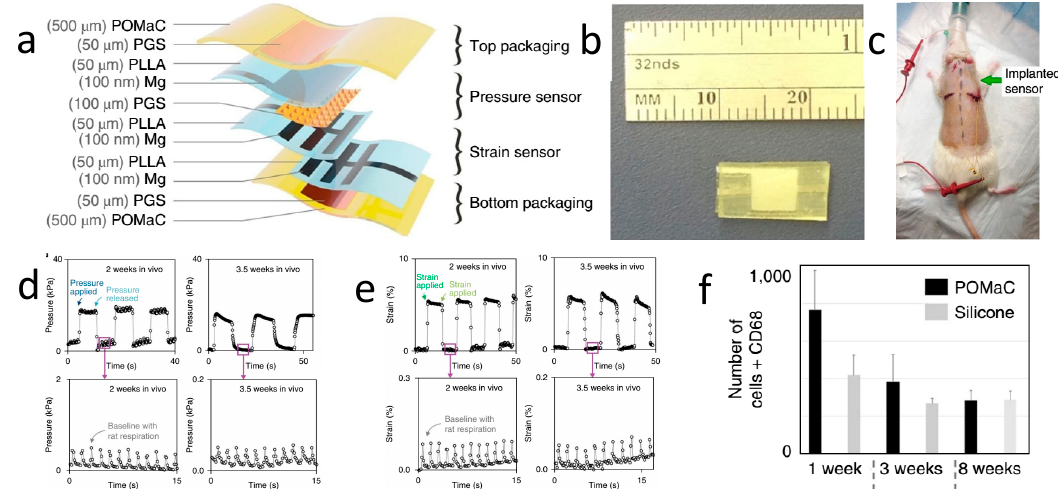
Figure 5. A stretchable and biodegradable strain and pressure sensor for orthopedic application. ( a ) Schematic diagram of the sensor space structure. ( b ) Optical image of the sensor. ( c ) The location of the implantable sensor. ( d ) Pressure signal detection two and 3.5 weeks after sensor implantation. ( e ) Strain signal detection two and 3.5 weeks after sensor implantation. ( f ) Results of immunohistochemistry. Reproduced with permission from [88].